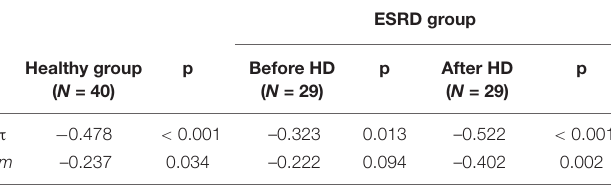
TABLE 3 | Spearman correlation coefficient between meanNN and the embedding parameters, tau ( τ ) and dimension ( m ).